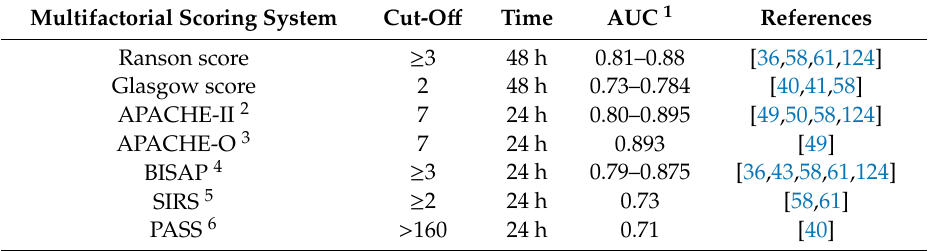
Table 1. Clinically relevant multifactorial scoring systems predicting disease severity in AP.